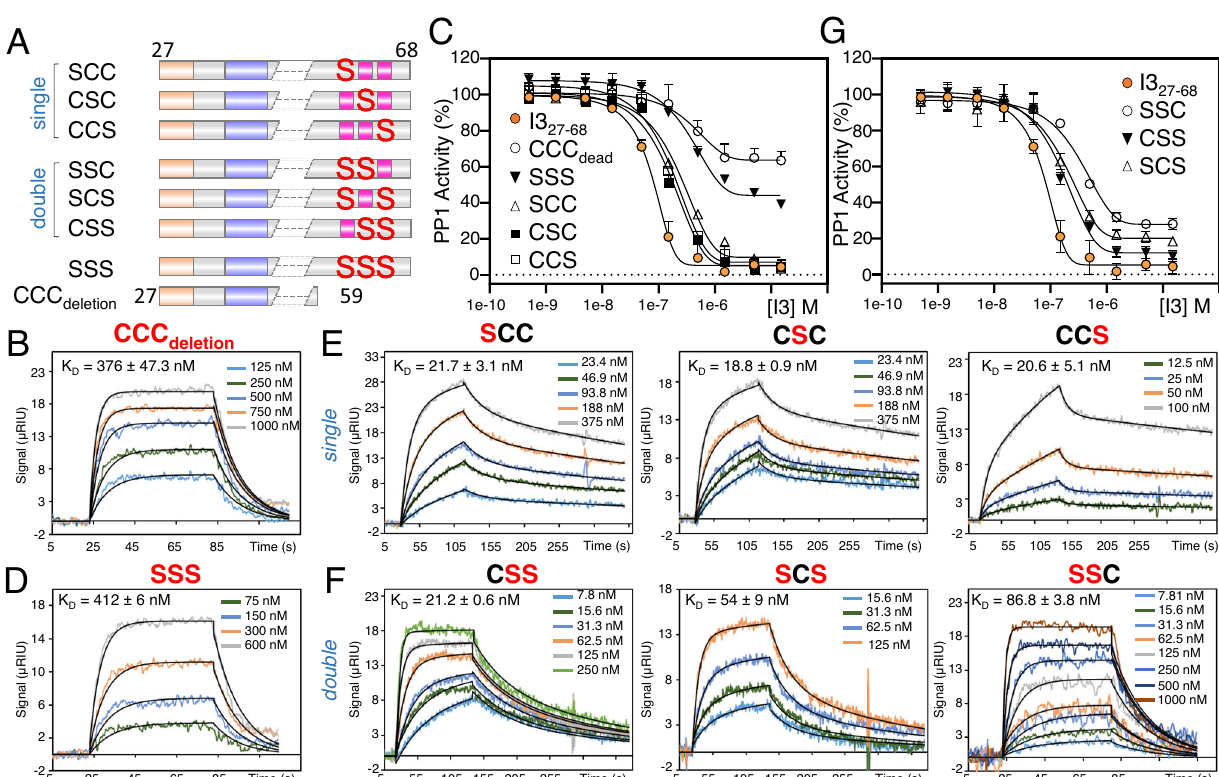
Fig. 3 | The fuzzy I3 CCC motif. A Domain structure of I3 constructs for studying the fuzzy I3 CCC motif. B SPR sensorgram between the I3 CCC deletion variant and PP1 α 7-330 . C PP1 IC 50 inhibition for I3 27-68 , I3 27-68 CCC deletion , I3 27-68 SSS and I3 27-68 singleC → S(SCC,CSC,CCS)mutants.Dataarepresentedasmeanvalues±SD, n =4 technical replicates. D SPR sensorgram between I3 27-68 SSS and PP1 α 7-330 . E SPR